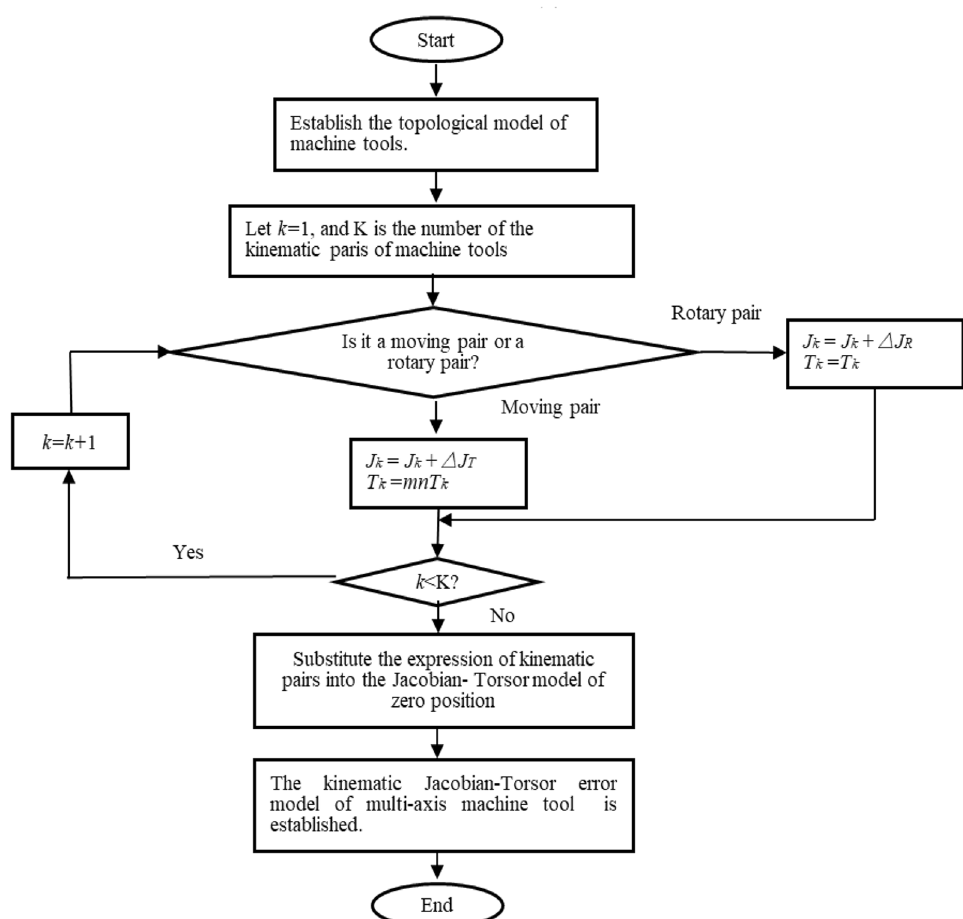
Figure 4 The process of modeling machine tool geometric error based on kinematic Jacobian-Torsor